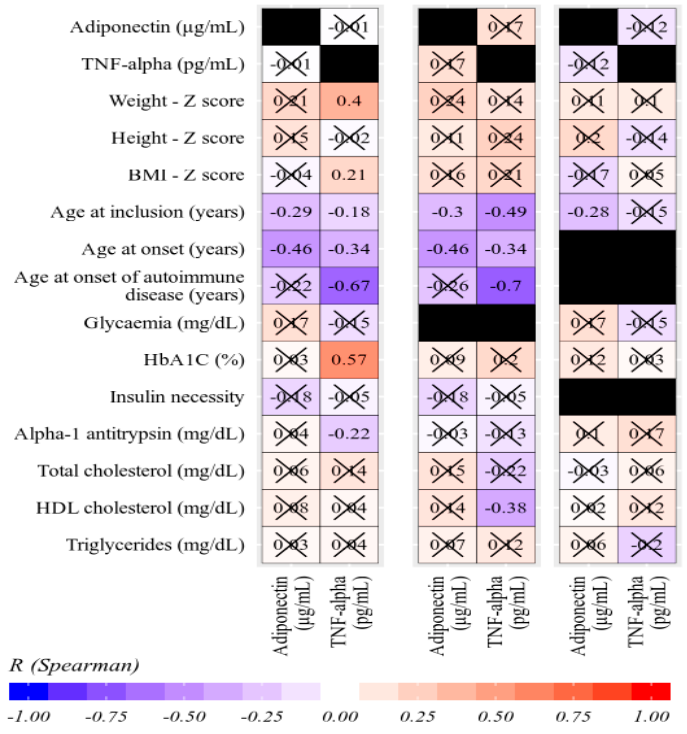
Figure 3. Correlation between adiponectin and TNF- α (Spearman’s R coe ffi cient). Reference values marked by dotted lines at 8.1 pg / mL for TNF- α and at 4, 7, and 10 µ g / mL for adiponectin (Spearman’s R coe ffi cients, statistically insignificant values crossed out, black boxes—parameters could not be corelated between the two